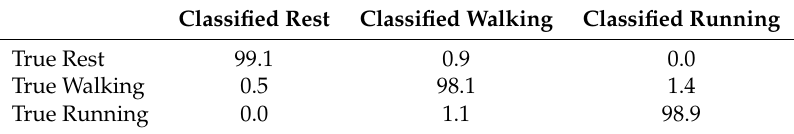
Table 6. Confusion matrix, using the supervised model (Sup-AXGZ8), of continuous data including walking, running and rest on a per sample basis. All calculated per person and then per class and displayed as a percentage.